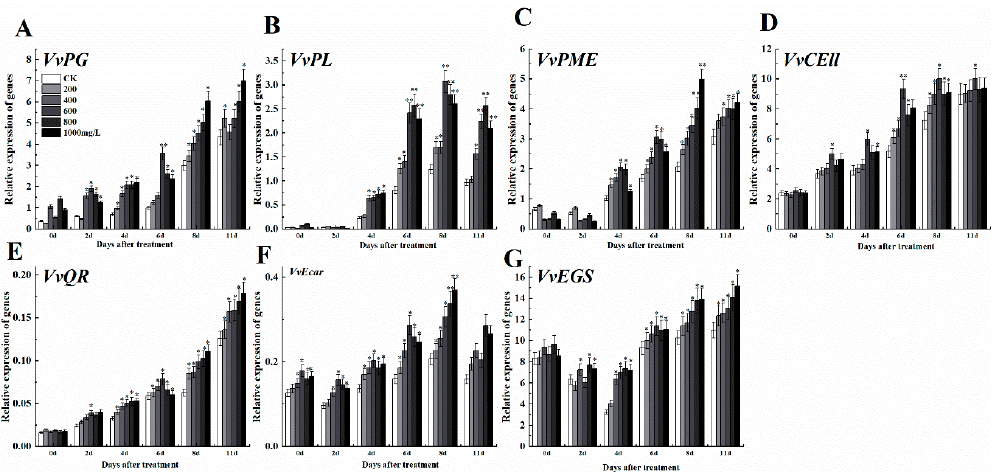
Figure 5. Effect of ethephon on ripening-related genes expression in grape. The expression levels of softening-related genes ( A ) VvPG , ( B ) VvPL , ( C ) VvPME , and (D) VvCELL . Aroma synthesis-related gene expression levels of ( E ) VvQR , ( F ) VvEcar , and ( G ) VvEGS . Ethephon was used in different concentrations (200, 400, 600, 800, and 1000 mg/L) and in a time course experiments (2, 4, 6, 8, and 11 d). Values are means ± SD of three biological replicates. * Significant differences compared with the control (water-treated fruits) sample at p < 0.05, ** Significant differences compared with the control (water-treated fruits) sample at p < 0.01 using Student’s test.